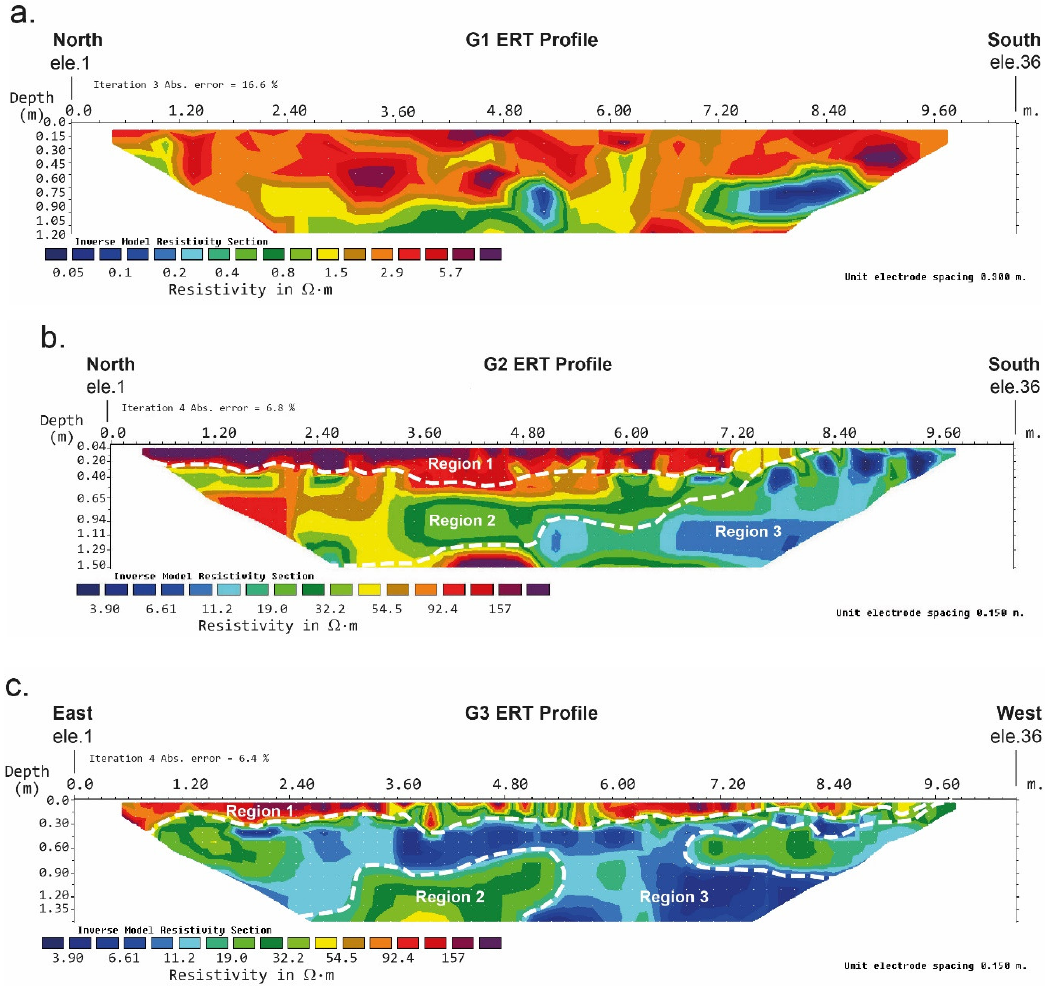
Figure 5. Electrical resistivity sections of profiles G1 ( a ), G2 ( b ), and G3 ( c ).